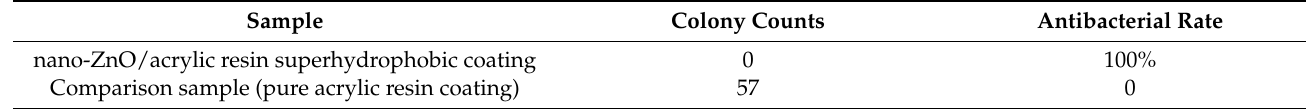
Figure 13. SEM image of sample prepared with resin-to-ZnO ratio of 1:4 ( a ) before and ( b ) after sanding 10 times. Table 1. Antibacterial properties of nano-ZnO/acrylic resin and pure acrylic resin. Sample Colony Counts Antibacterial Rate nano-ZnO/acrylic resin superhydrophobic coating 0 100% Comparison sample (pure acrylic resin